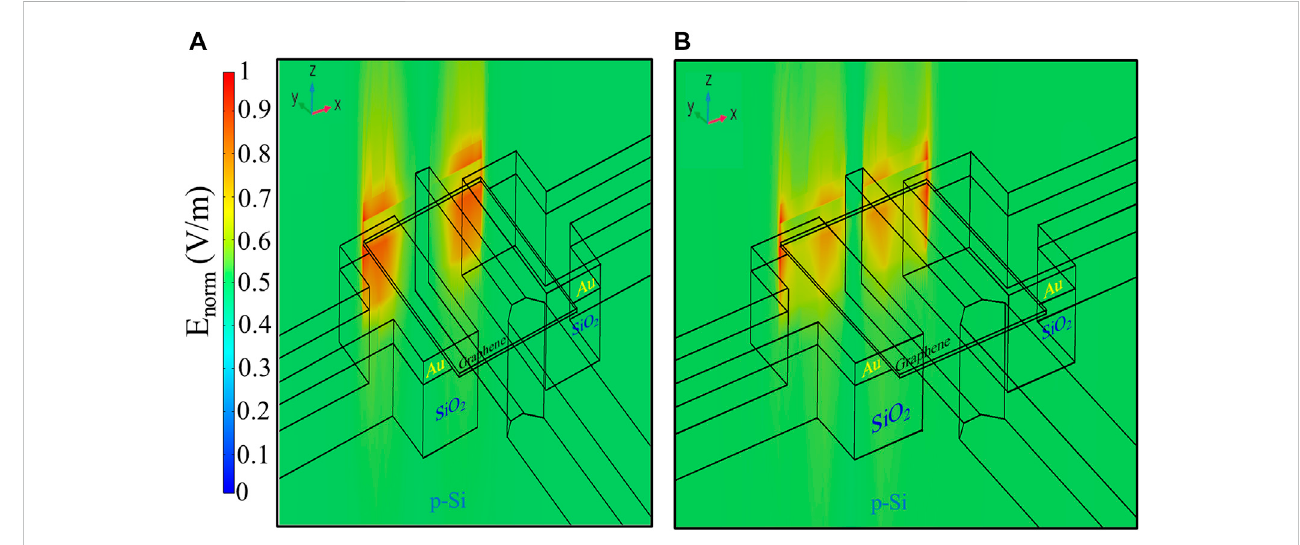
FIGURE 2 Simulations of a single unit-cell with an excitation of x-polarized (along the SR ’ s axis) E norm - fi elds at Y = +8 μ m (from the center), 0.8 THz resonant frequency, and graphene conductivity of (A) 0.2 mS “ off ” state and (B) 1.6 mS “ on ” state.